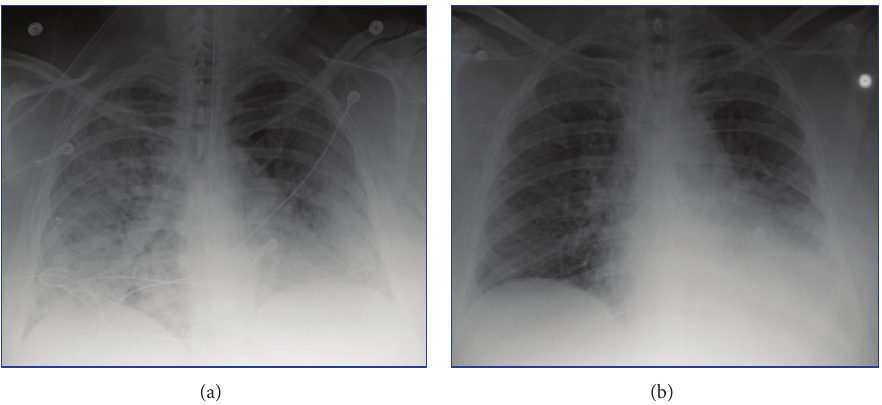
Figure 2: (a) CXR from admission showing bilateral extensive pulmonary infiltrates, suggestive of florid vasculitis. (b) CXR upon discharge emphasizing resolution of the pulmonary infiltrates following treatment with plasmapheresis, induction cyclophosphamide, and high dose methylprednisone.